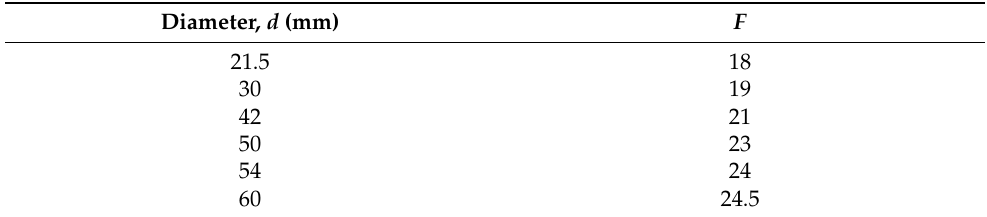
Table 3. Values of F for different diameters according to American Society for Testing and Materials (ASTM)